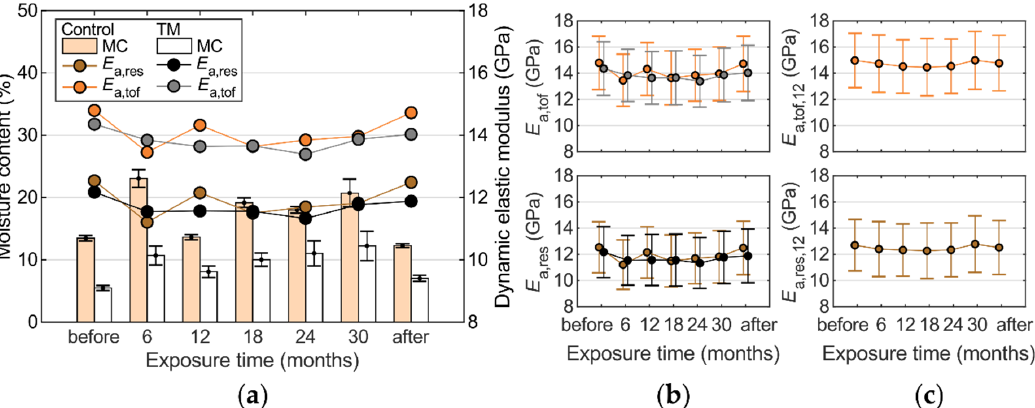
Figure 8. Moisture content (MC) and dynamic elastic moduli ( E a ) of ‘exposed’ control and / or TM boards by exposure time: ( a ) MC (mean ± standard deviation) and E a (mean), ( b ) E a (mean ± standard deviation), and ( c ) E a adjusted to 12% MC (mean ± standard deviation) of control boards (legend in a ).